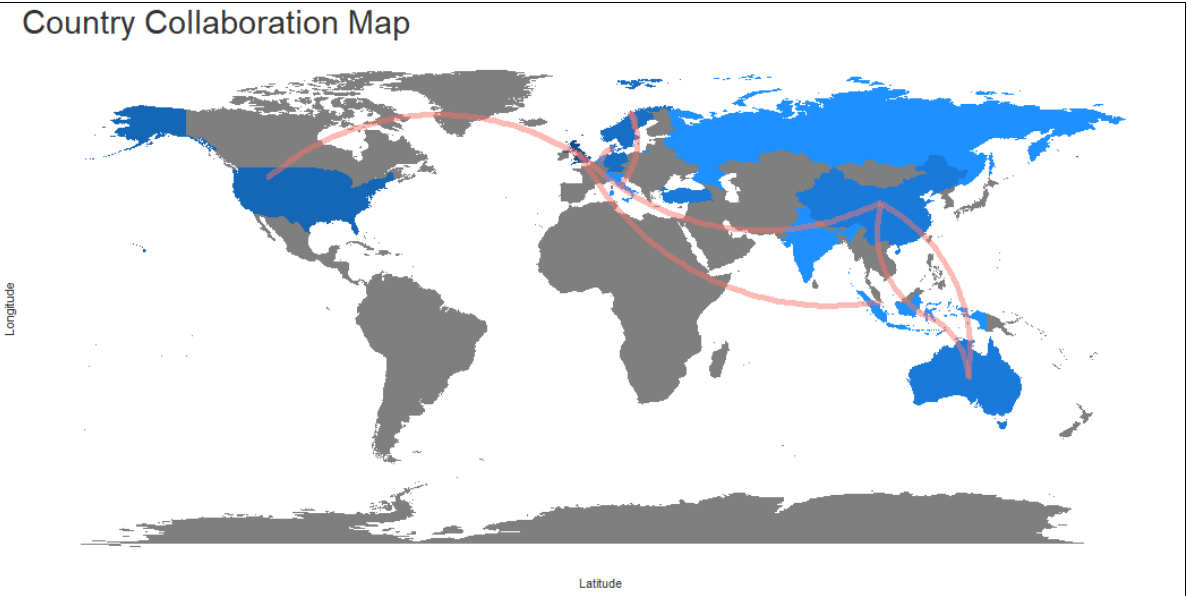
Figure 5. Most prolific institutions and collaborative networks by